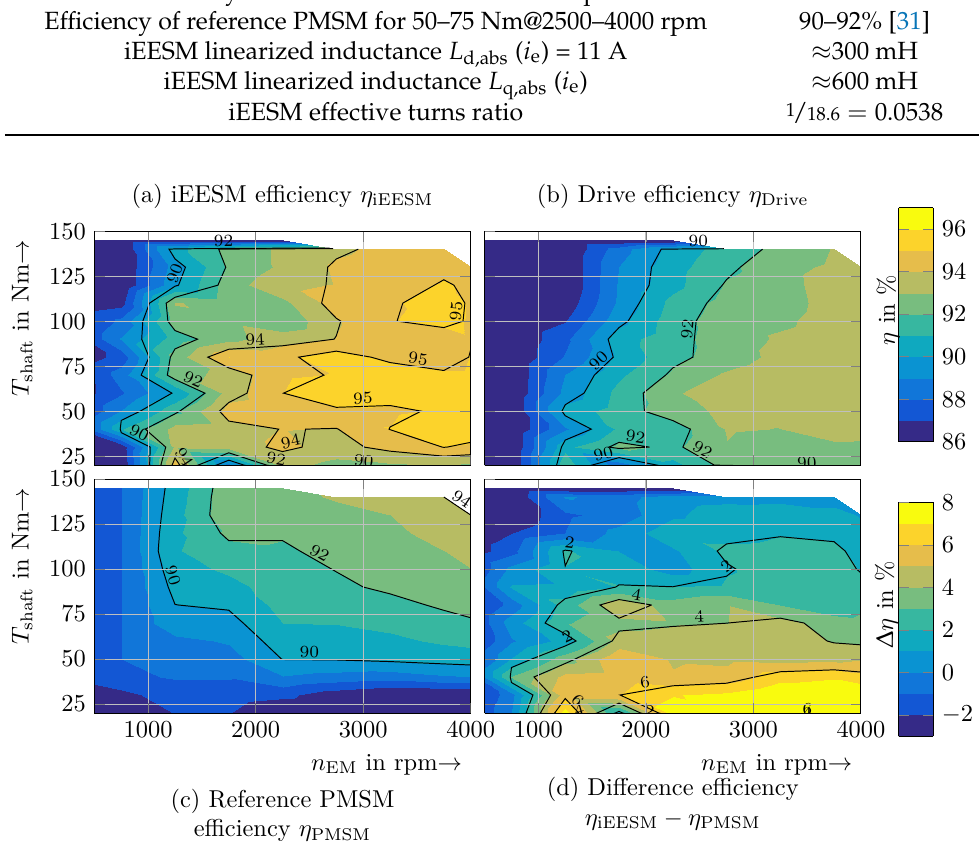
Figure 19. ( a , b ) measured efficiency with operation strategy MTPA on the test bench, ( c ) results from reference PMSM [31], ( d ) difference in efficiency η iEESM